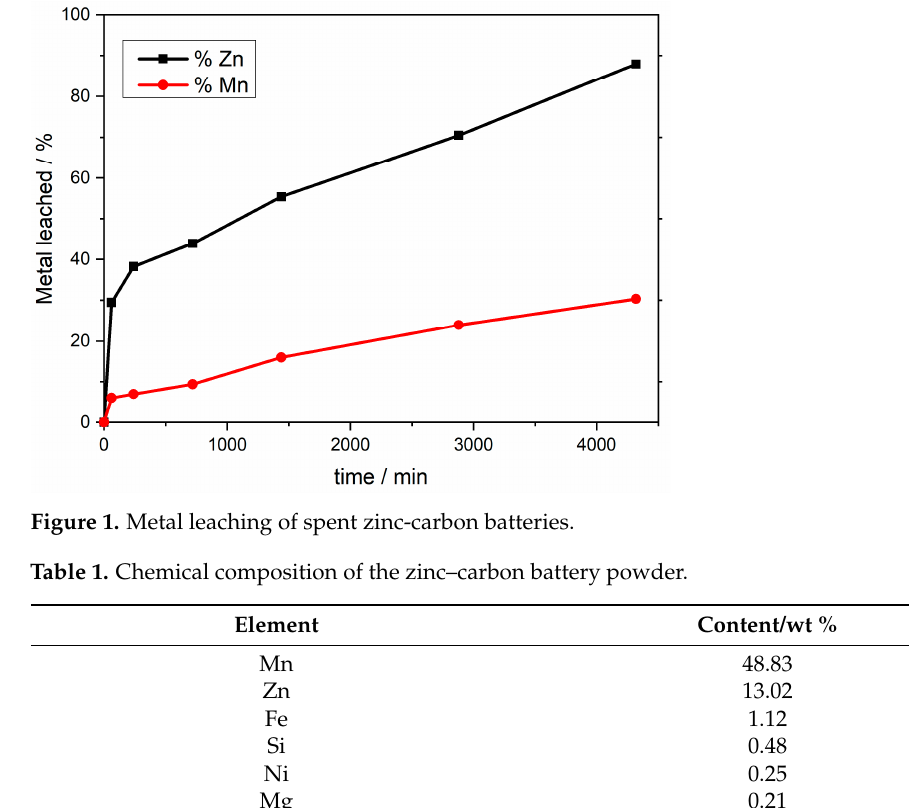
Table 1. Chemical composition of the zinc–carbon battery powder.